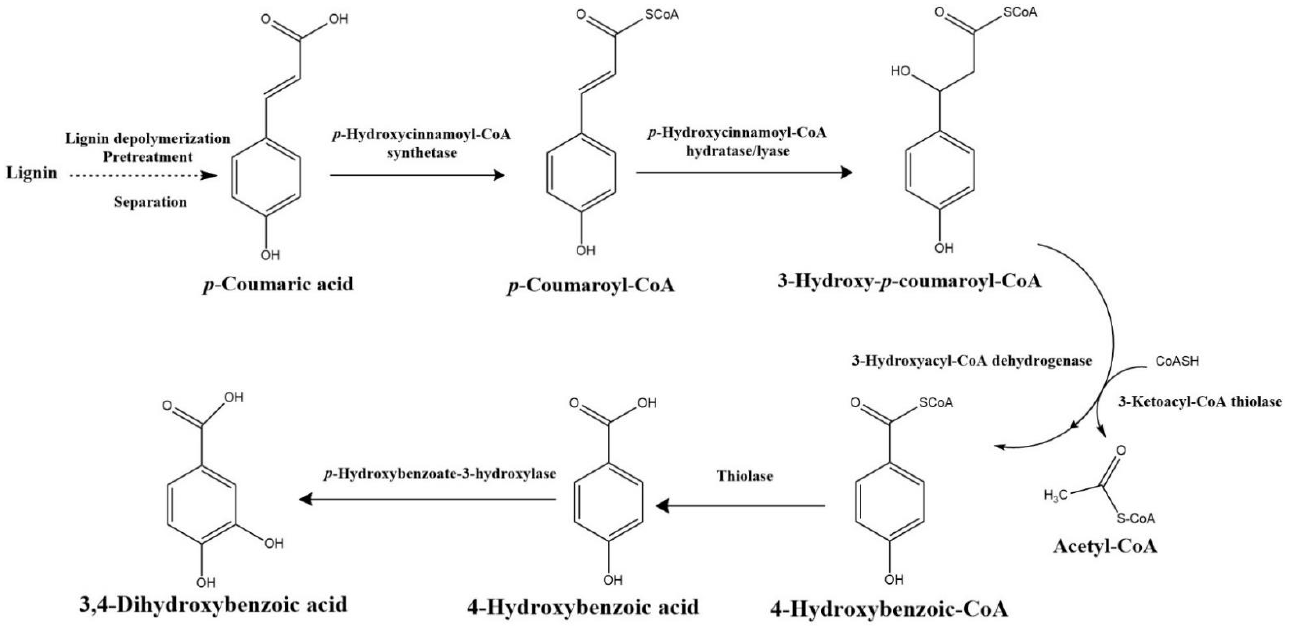
Figure 7. 3,4-dihydroxybenzoic acid is obtained via the β -oxidation-like pathway. The side chain of p -coumaric acid is firstly activated and then gradually degraded, with the release of acetyl-CoA for biosynthesis through the central metabolism or for energy [92].